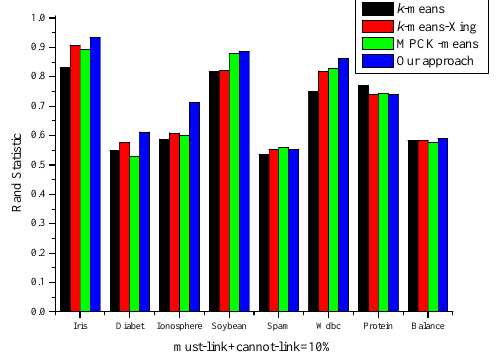
Fig. 8. Clustering results with 10% randomly selected con- straints (This means in a dataset of 100 points, we randomly select 10 constraints without setting ratio between must-link and cannot-link)